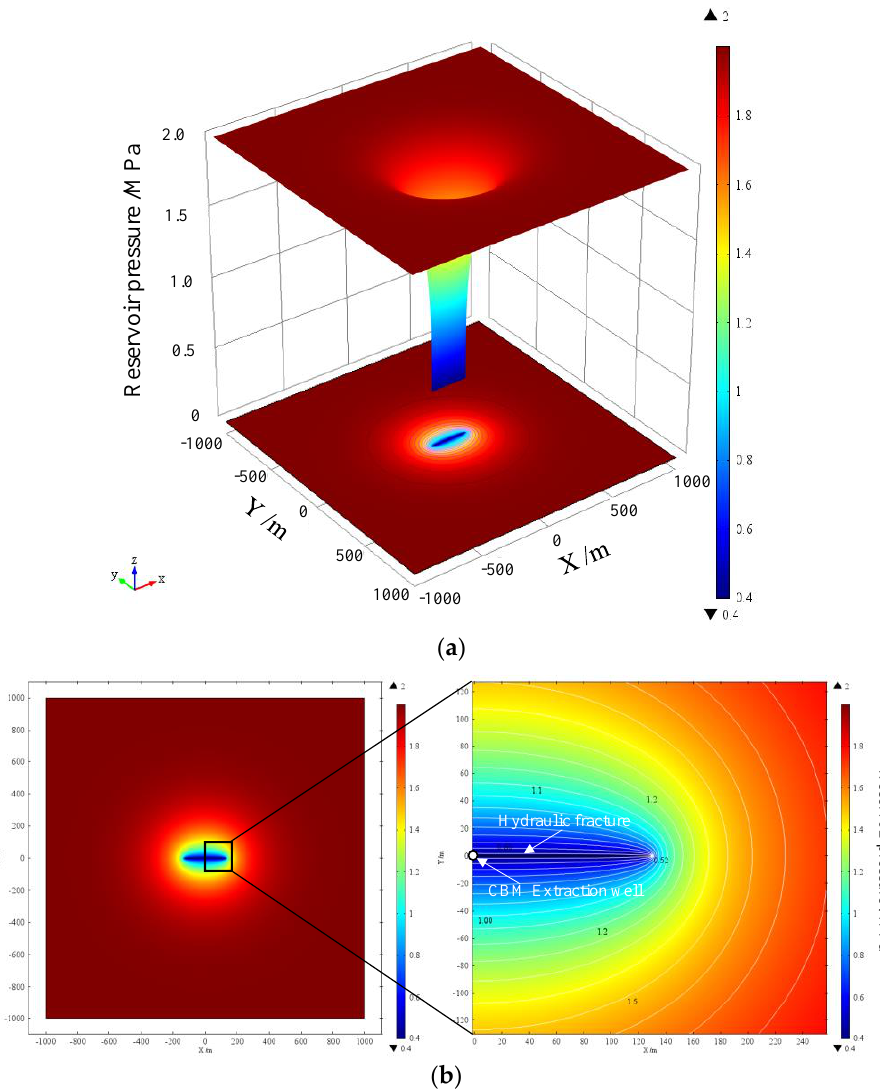
Figure 6. Reservoir pressure distribution after mining for 5 years when a hydraulic fracture half- length is 130 m: ( a ) three-dimensional perspective, ( b ) two-dimensional perspective.